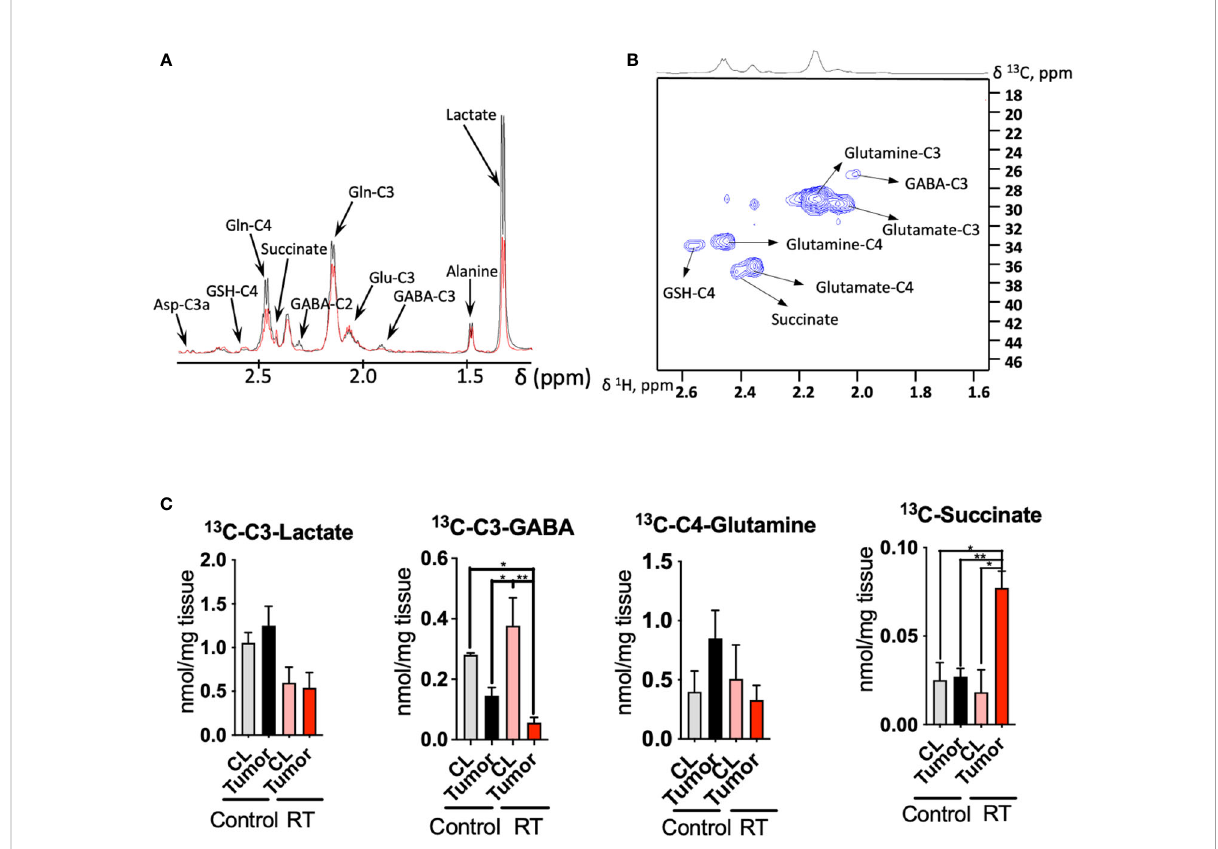
FIGURE 3 Radiotherapy enhances the 13C incorporation of glutamine to succinate in astrocytoma tissue: (A) , 1D HSQC NMR stack plot of spectra acquired on tumor tissue from a mouse from the control group (black) and undergoing radiotherapy (RT, red) displaying the resonances arising from 13 C labeling from [U- 13 C]-glutamine tracing experiments. Typical spectra are shown (resonance intensities normalized to tumor weight). (B) , 2D 1 H- 13 C HSQC Representative spectrum of a tumor sample from a mouse infused with [U- 13 C]-glutamine displaying the region between 1.6-2.6 ppm ( 1 H) and 18-46 ppm ( 13 C). (C) , Quanti fi cation of the [U- 13 C]-glutamine labeling on those metabolites showing a different degree of 13 C incorporation after radiation in tumor and contralateral regions. (data displayed as bar plots ± SEM, n=3, statistical signi fi cance assessed through a two-way ANOVA followed by Tukey HSD test, *, p<0.05; **, p<0.005). Only signi fi cant differences are indicated. RT was